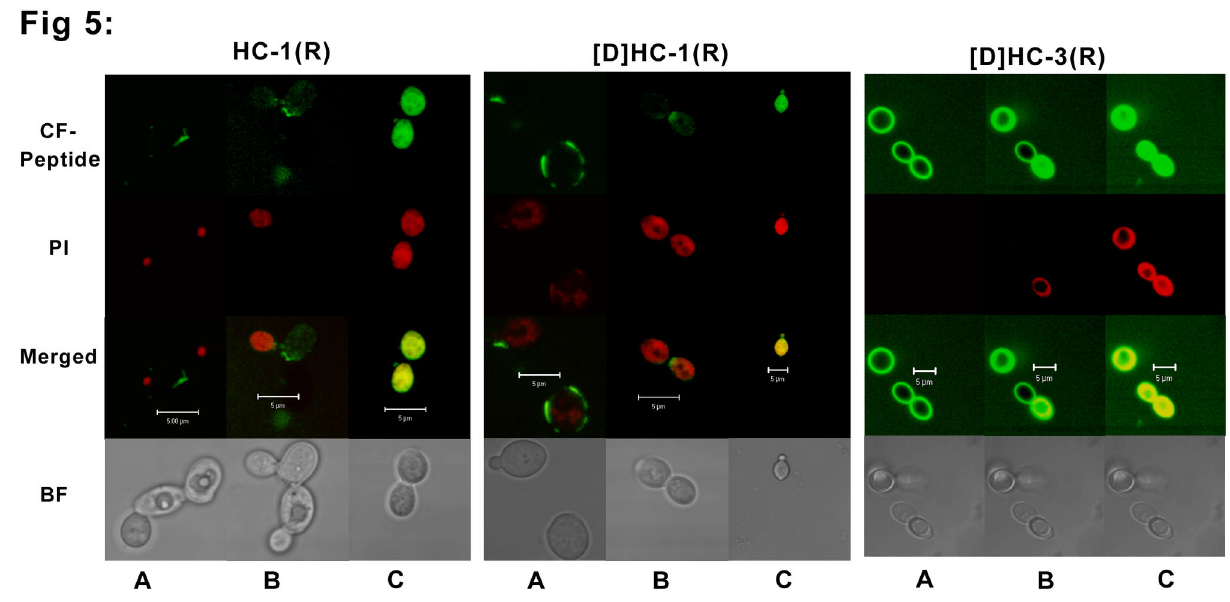
Figure 5. Confocal microscope images of C. albicans in the presence of CF-labeled HC-1(R), [D]HC-1(R) and [D]HC-3(R). C. albicans cells (1 x 10 7 ) were treated with CF labeled peptide and 2 µg/ml of PI. The treated cells were incubated for different time points to capture different events during the process of peptide entry into the cell. Panel A represents an early time point wherein the peptide is found over the membrane. Panel B represents the stage where, the peptide diffuses into the cells (green) and the dying cells are taking up PI stain (red) Panel C represents dead cells (yellow in the merged panel) showing the diffused peptide (green) and the diffused nuclear material (red). The bar represents 5 µm. doi: